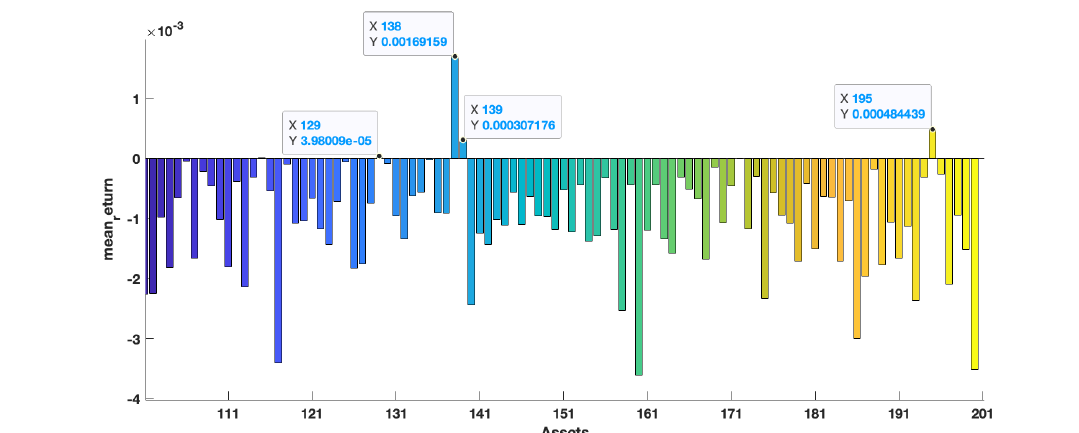
Figure 4. The mean return of the out-of-sample data for N = 100.